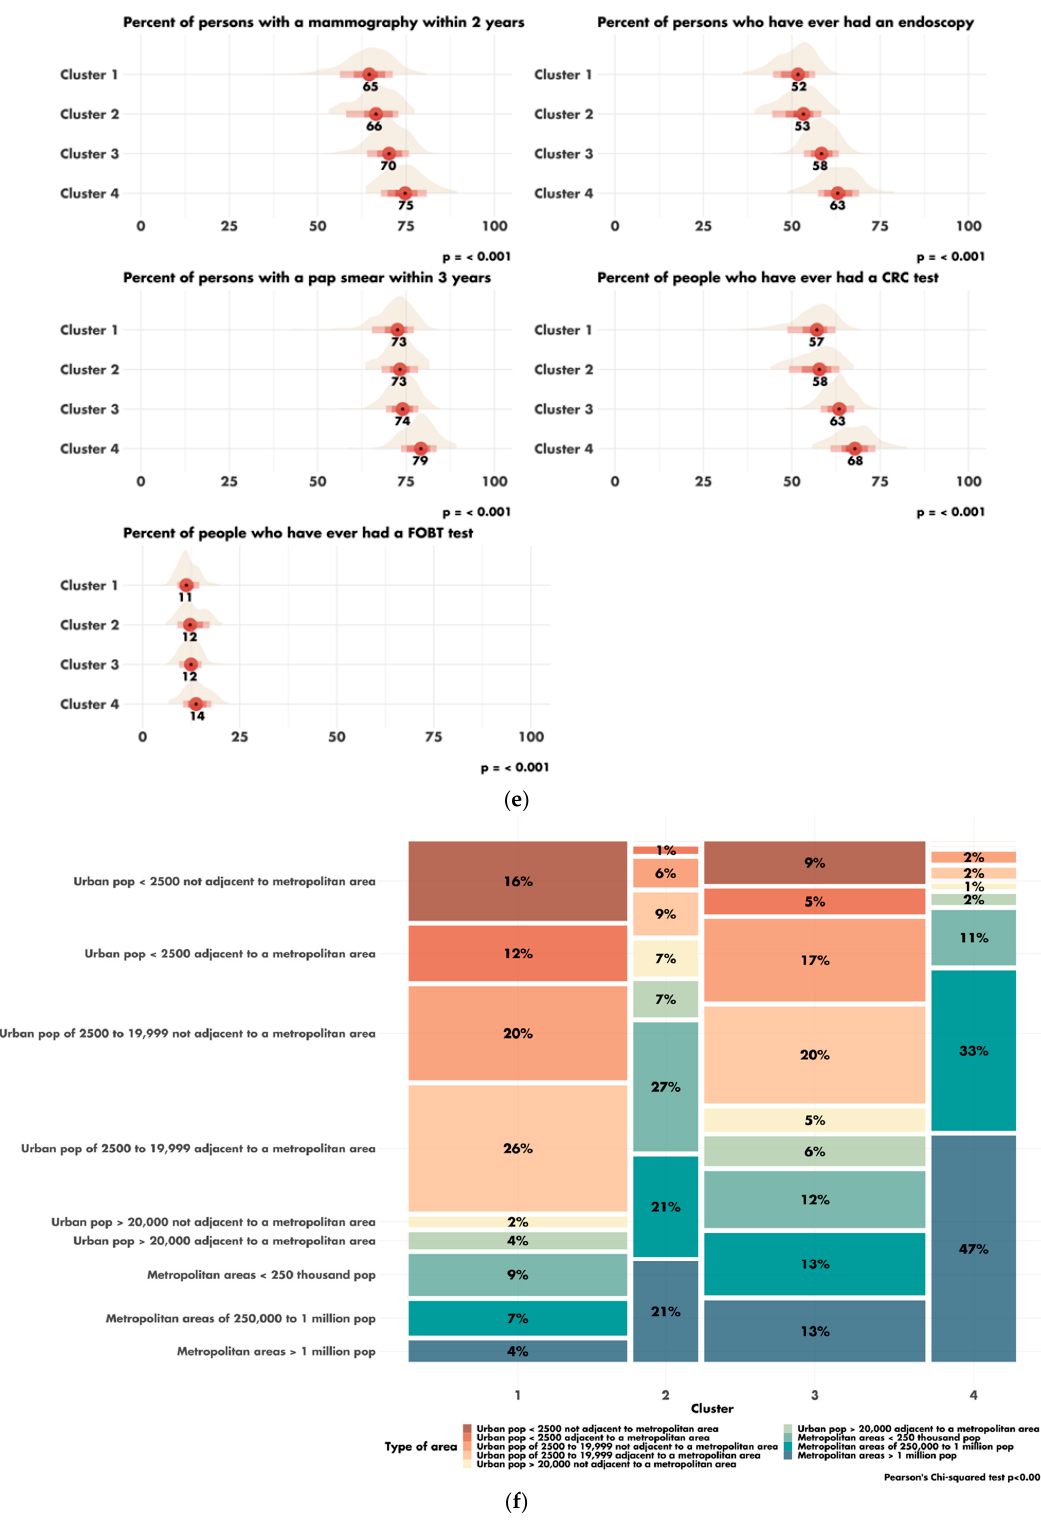
Figure 4. Characteristics of the clusters: ( a ) distribution of the variables related to education; ( b ) distribution of the variables related to income and poverty; ( c ) distribution of the variable related to employment; ( d ) distribution of the variables related to immigration; ( e ) disparity in access to care between the four clusters. Access to care is most difficult in cluster 1 and easiest in cluster 4. FOBT = Fecal Occult Blood Test. CRC = Colorectal Cancer Screening Blood Test. ( f ) Rural/urban distribution of the population in each